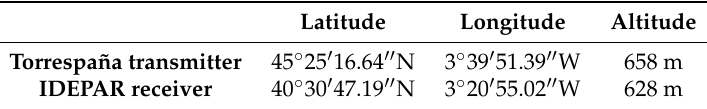
Figure 15. Received power levels provided by the Torrespaña Illuminator of Opportunity (IoO) in the considered radar scenario. Table 8. IoO and IDEPAR receiver emplacement coordinates.